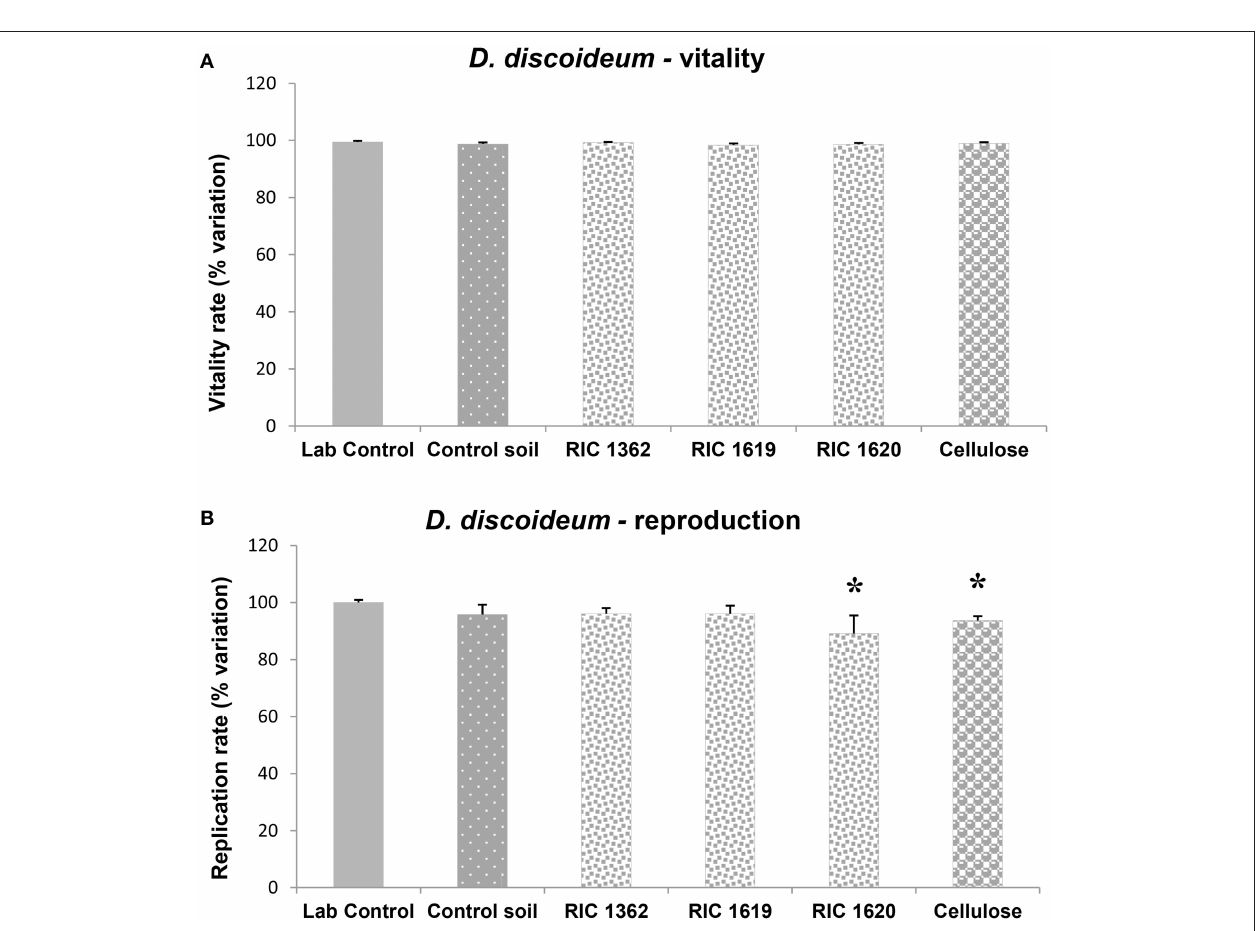
FIGURE 2 | Survival (A) and reproduction rate (B) of D. discoideum amoebae after exposure to the elutriate samples. Data, expressed as % variation (A) and % variation with respect to lab control (B) , represent the mean ± SD of at least five replicates. *Indicates statistically significant differences with respect to lab control values ( p < 0.05 Mann–Whitney U -test). RIC 1362, RIC 1619, RIC 1620, Mater-Bi soils; Cellulose, soil containing cellulose reference material.